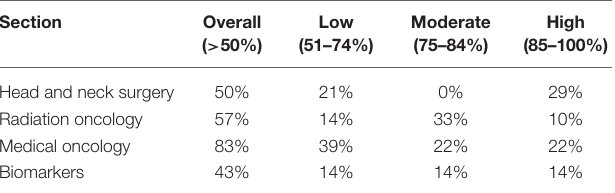
TABLE 1 | Level of consensus in each